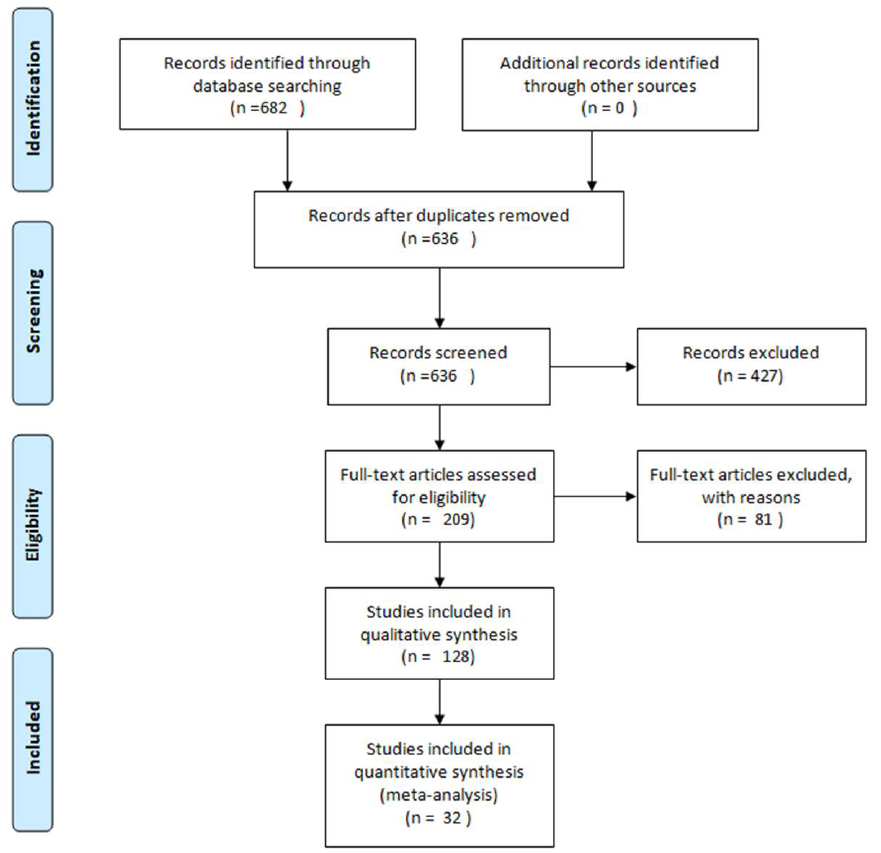
Figure 1. Methodology description of articles selected for this review using Prisma flow diagram [8].